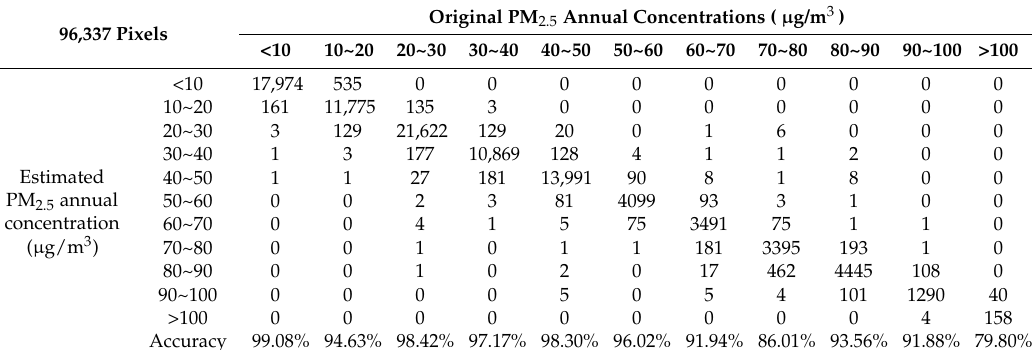
Table 3. The confusion matrix of the original vs. estimated PM 2.5 annual concentrations by the deep CNN model fed by the two influencing factor data, terrain and